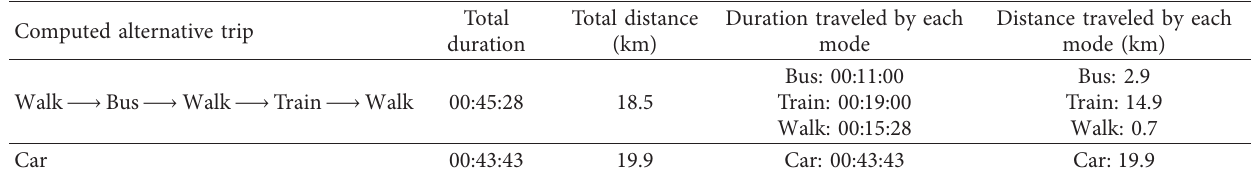
Table 4: An observed trip in our dataset for which computed PT alternative is almost as fast as car. Trip origin is “S¨orn¨aisten rantatie 7b, Helsinki,” and destination is “Kulovalkeantie 6, Espoo,” and departure time and date are 21:00 and 9.8.2017. Total Computed alternative trip Walk ⟶ Bus ⟶ Walk ⟶ Train ⟶